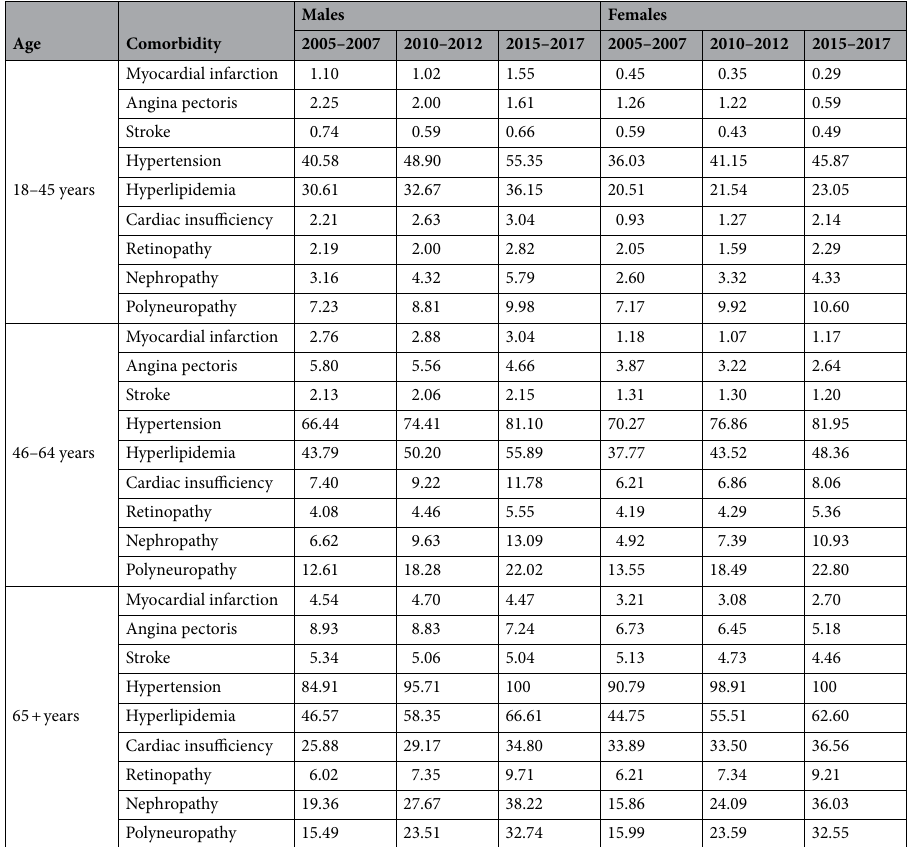
Table 2. Period prevalence of single comorbidities in T2D patients (in percent) by age group, sex and time period.